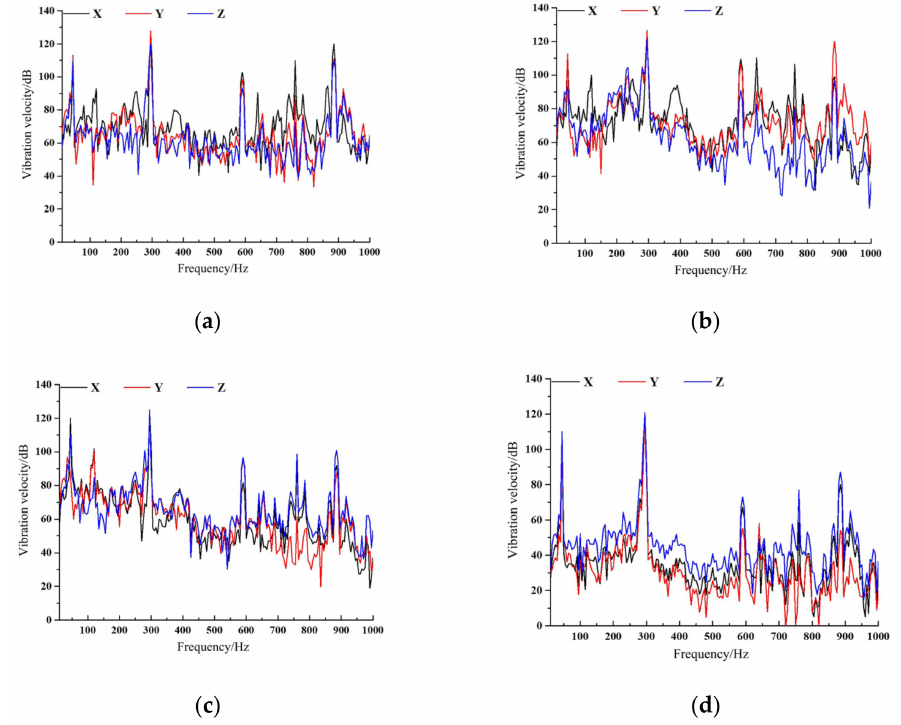
Figure 16. The frequency spectrum of the vibration of the pump unit caused by fluid excitation on the inner surface of the pump: ( a ) export flange; ( b ) import flange; ( c ) connecting plate; ( d )